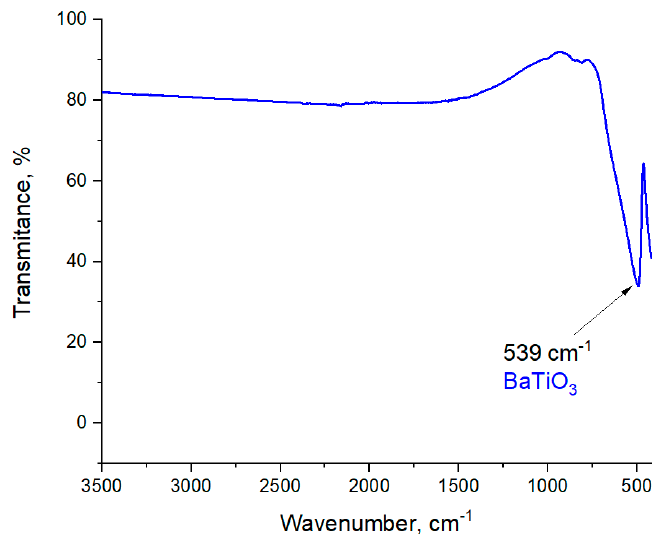
Figure 4. Fourier Transform Infrared (FT-IR) spectrum of barium titanate.